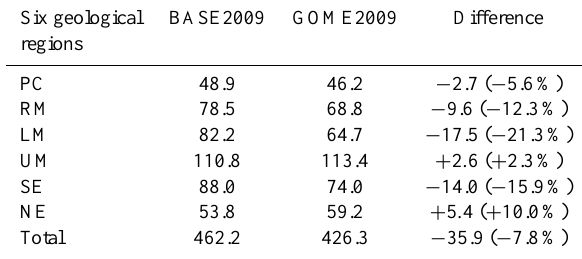
Table 1. NO x emissions inventory changes from baseline emissions inventory for August of 2009 (BASE2009) and GOME-2-adjusted emission inventory (GOME2009) over six geological regions of the US (PC: Pacific Coast, RM: Rocky Mountain, LM: Lower Middle, UM: Upper Middle, SE: Southeast, and NE: Northeast) for August 2009 (in unit ofGgN). The parentheses indicate the changes in the amounts of emissions in each geological region (in